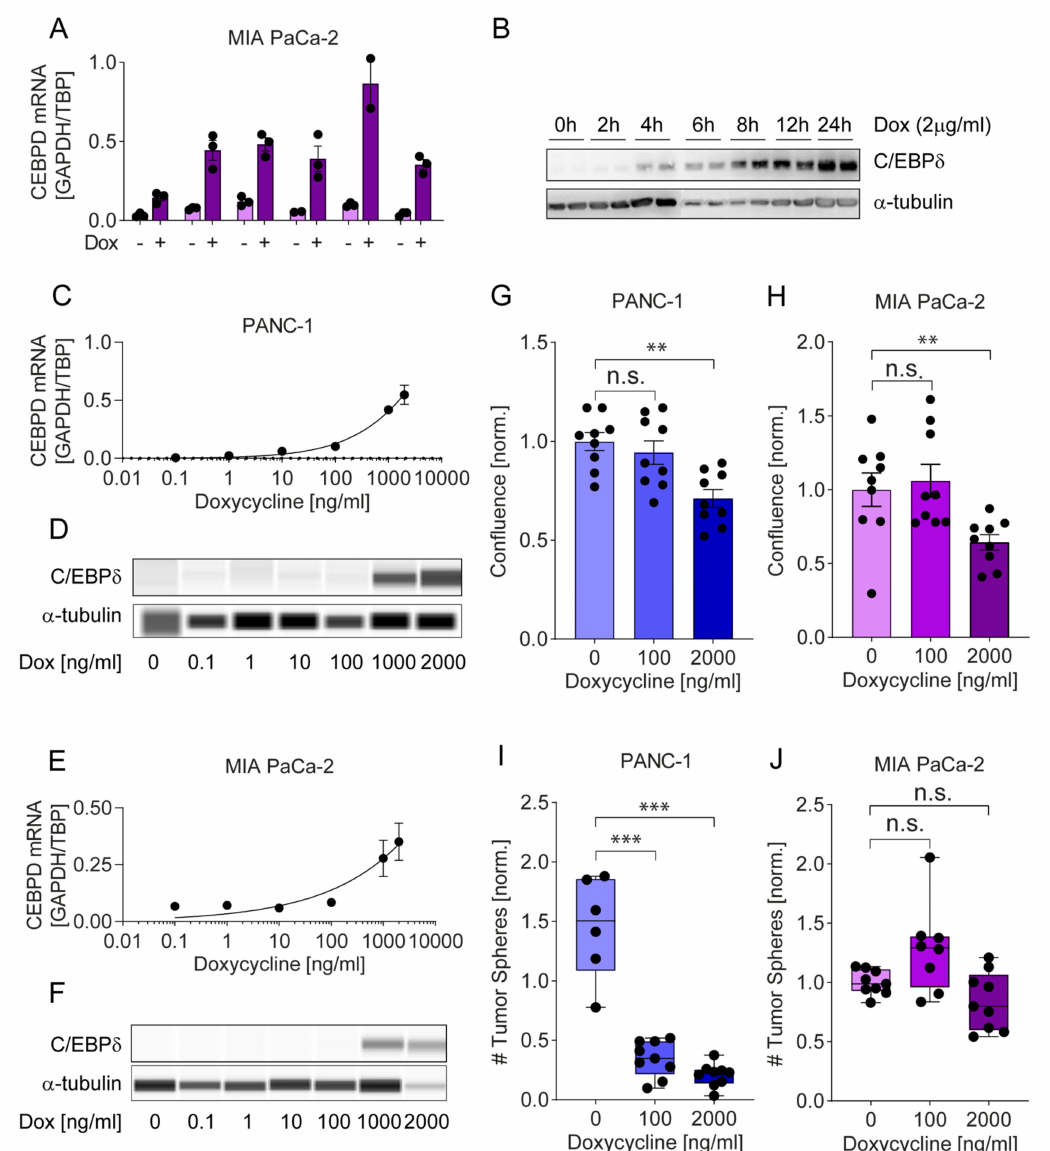
Figure 5. Doxycycline dose-dependent induction of C / EBP δ regulates proliferation and tumor sphere formation. ( A ) Single clones of MIA PaCa-2 cells, transduced with a doxycycline-inducible C / EBP δ over-expression plasmid, show increased C / EBP δ mRNA levels upon induction. ( B ) C / EBP δ induction in MIA PaCa-2 cells over time. The uncropped blots are provided in Figure S3A ( C – F ) Doxycycline dose-dependently induces C / EBP δ in both transduced MIA PaCa-2 and PANC-1 cells. The uncropped blotsareprovidedinFigureS3B,C.( G , H )Proliferationismildlydecreasedby100ng / mLandsignificantly reduced by 2000 ng / mL doxycycline in PANC-1 (** p = 0.0012) and MIA PaCa-2 (** p = 0.0078) cells. ( I , J ) Tumor sphere formation in soft agar is significantly reduced by 100 and 2000 ng / mL doxycycline in PANC-2 (*** p = 0.0004). A similar yet not significant trend is observed in MIA PaCa-2 with 2000 ng / mL doxycycline. Dox: Doxycycline. n.s.: not significant, *** p <